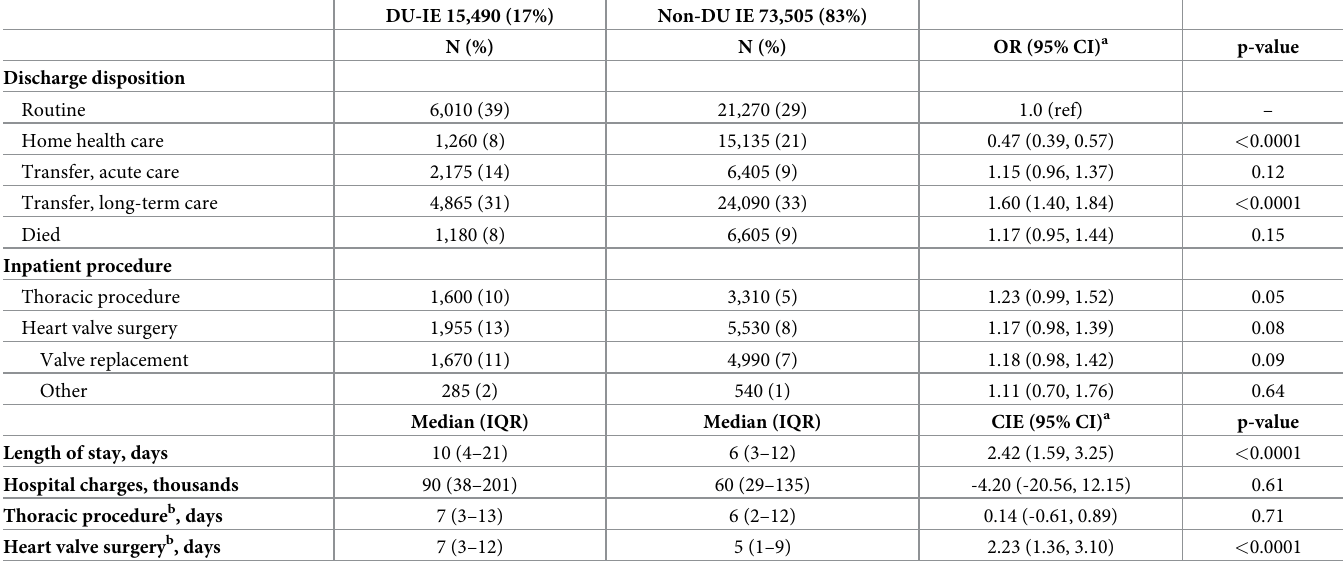
Table 4. Association between drug use, compared to no drug use, on inpatient